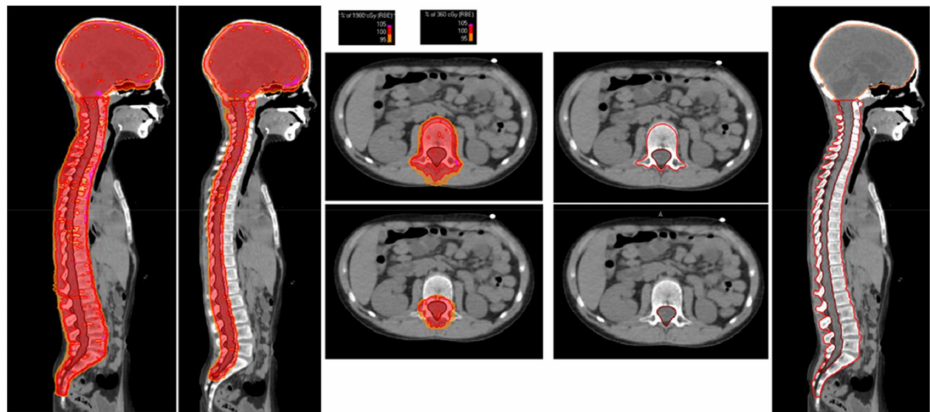
Figure 1. The right side shows the target volumes drawn for the contouring of the CSI. The left side reports the dose distributions of the first phase (19.8 GyRBE to the brain plus the whole vertebral body) and the second phase (16.2 GyRBE to the brain plus the subarachnoid space and the spinal nerve roots) of the